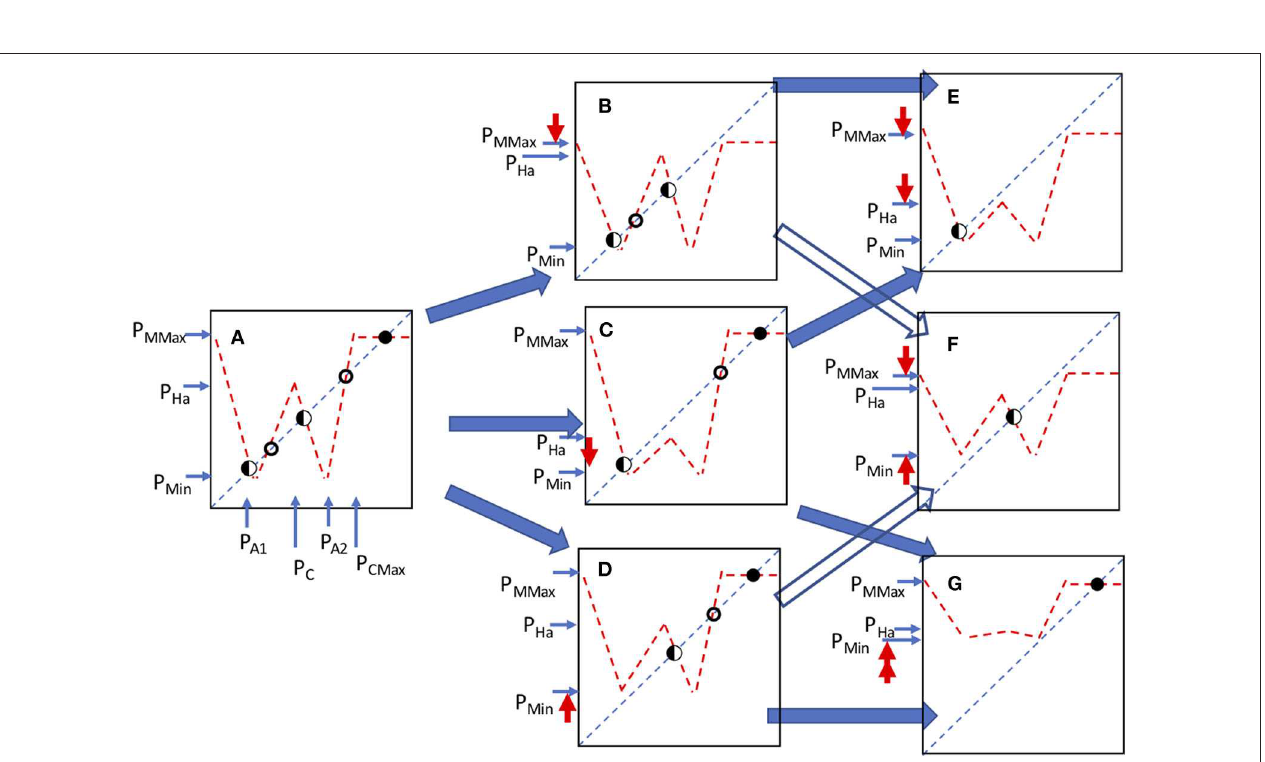
FIGURE 13 | All the qualitatively distinct structural arrangements of the model. Circles indicate the position and nature of the equilibrium points, an open circle indicates an unstable point, closed circle a stable point and half closed circle is either a stable point or the focus of a chaotic attractor, depending on the eigenvalue. Bold (red) arrows pointing up or down indicate the parameter change in going from one panel to the next, according to the dark (blue) shaded arrows indicating change from panel to panel. A is original orientation. A moves to either B , C , or D , depending on the parameter change indicated by the red arrows going up or down. B moves to either E or F depending on parameter change indicated by the red arrows, C moves to either E or G depending on parameter change indicated by the red arrows, D moves to F or G depending on parameter change indicated by the red arrows.